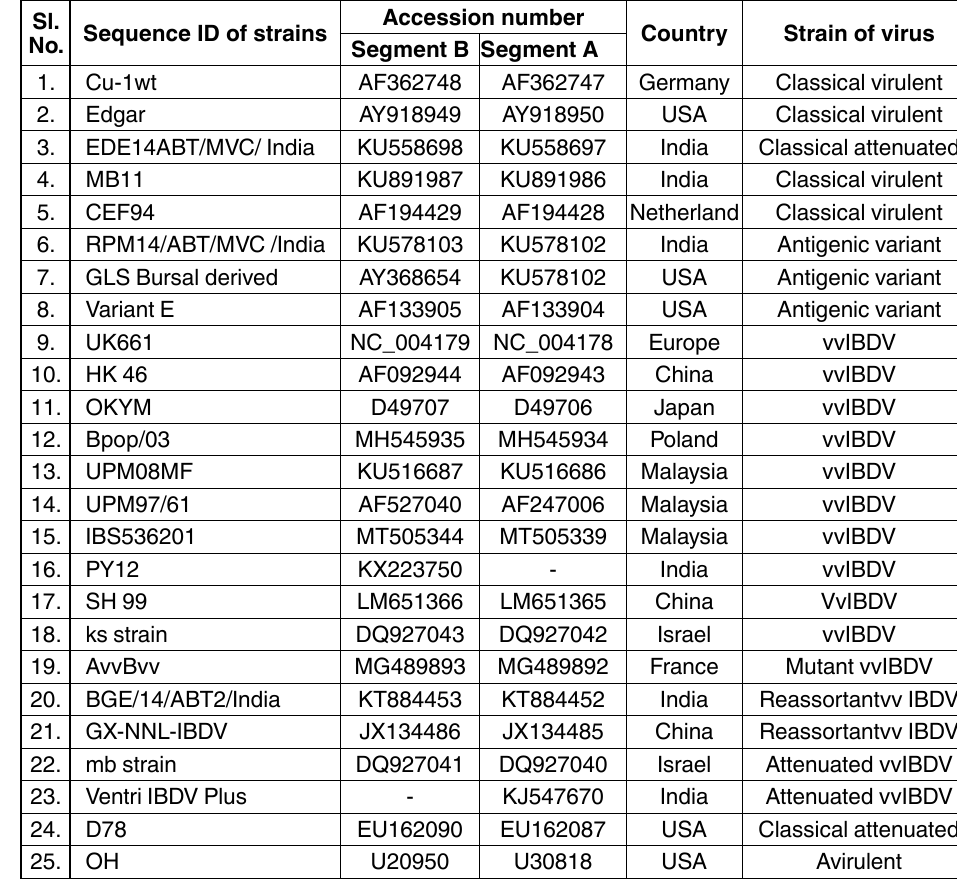
table 4. Strains of virus selected from GenBank, NCBI for phylogenetic analysis sl. sequence iD of No.